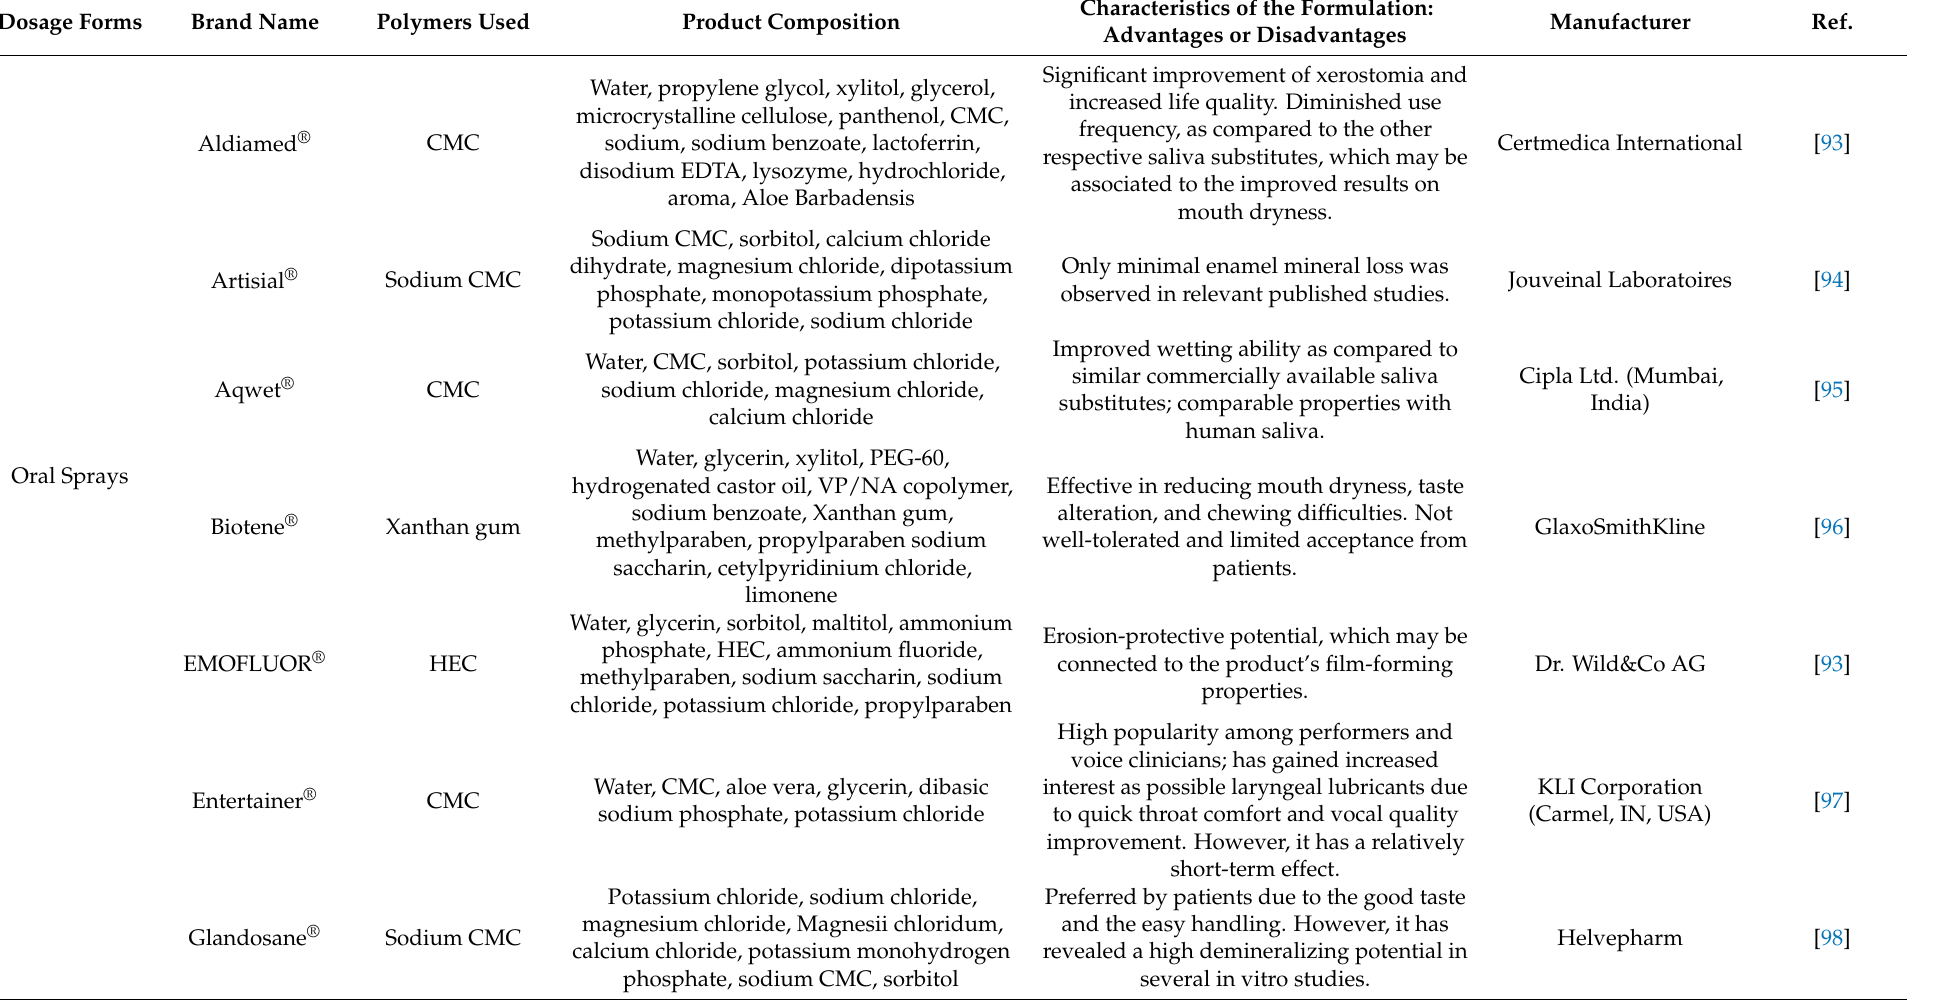
Table 2. Commercially available saliva substitutes mentioned in published